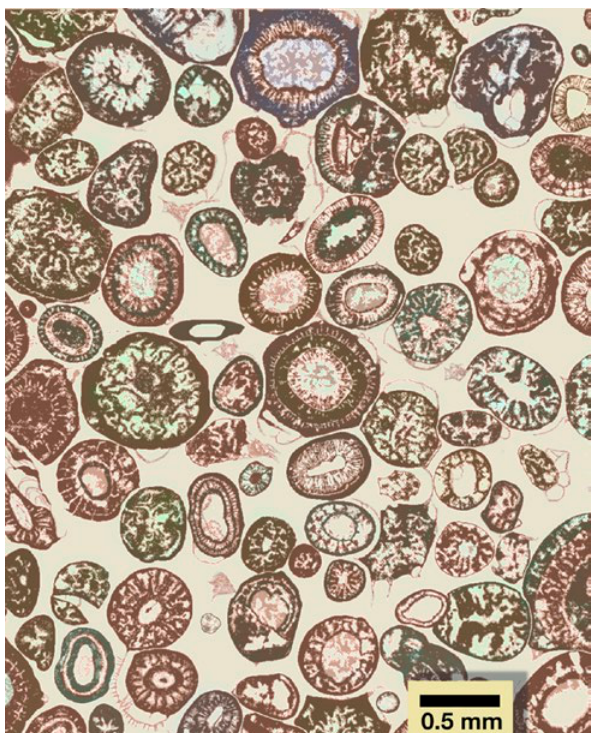
Figure 57. Calcite oolites in a calcitic matrix further emphasise the point that gelatinous oolite precursors do not have to be different in composition from the gelatinous lime muds in which they form. They differ in precursor gel structure in that the oolitic nuclei must be ‘close packed’ and synerectic while the host mud is an open- meshwork porous gel through which very small particles can dif- fuse. These oolites from Short Creek, Missouri, (Lindgren 5 , 1933, p. 267) show the evidence of their soft gelatinous precursors in the mutual indentation and distortion, fracture fragments, composites, overgrowths, and syneresis shrinkage